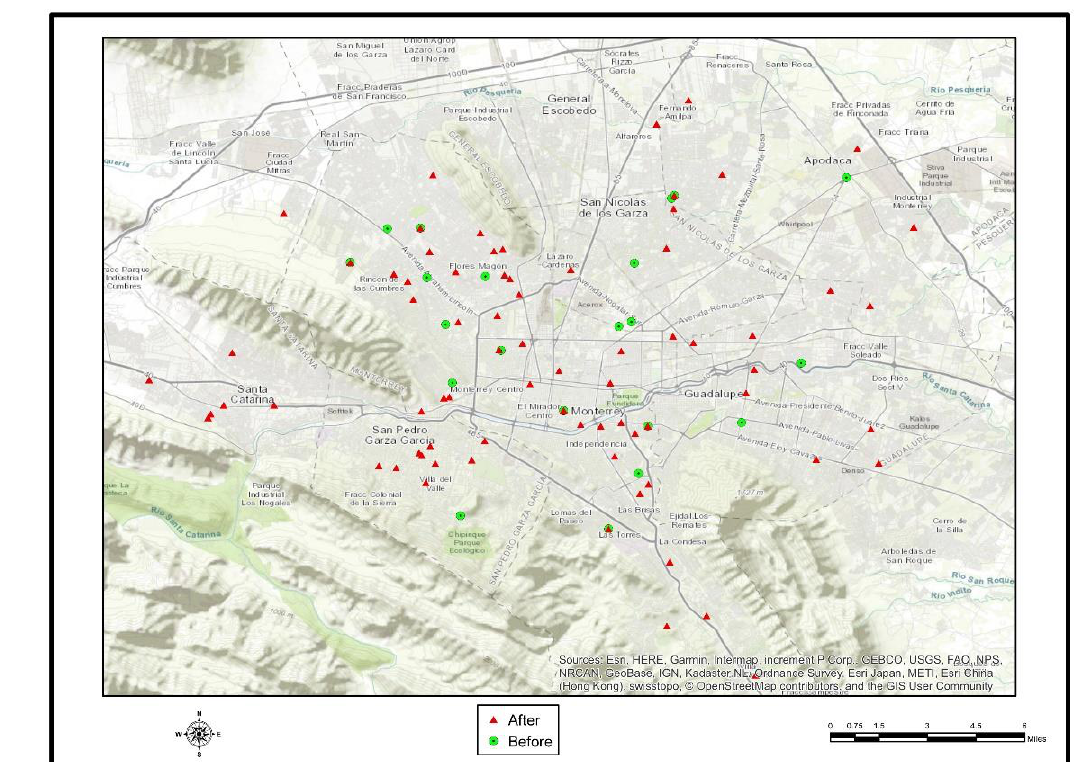
Figure 7. Showing the changes in the incidence of respiratory diseases before and after Hurricane Alex.